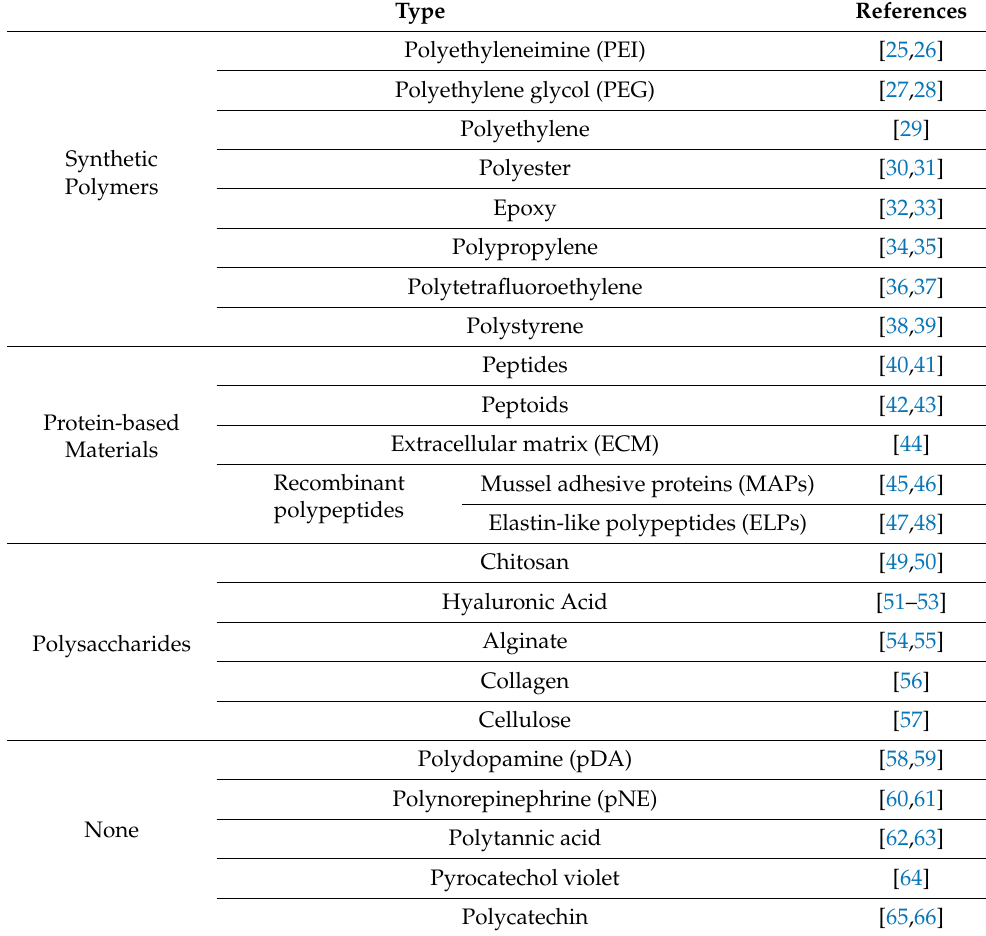
Table 1. Types of backbone materials for polyphenolic functional